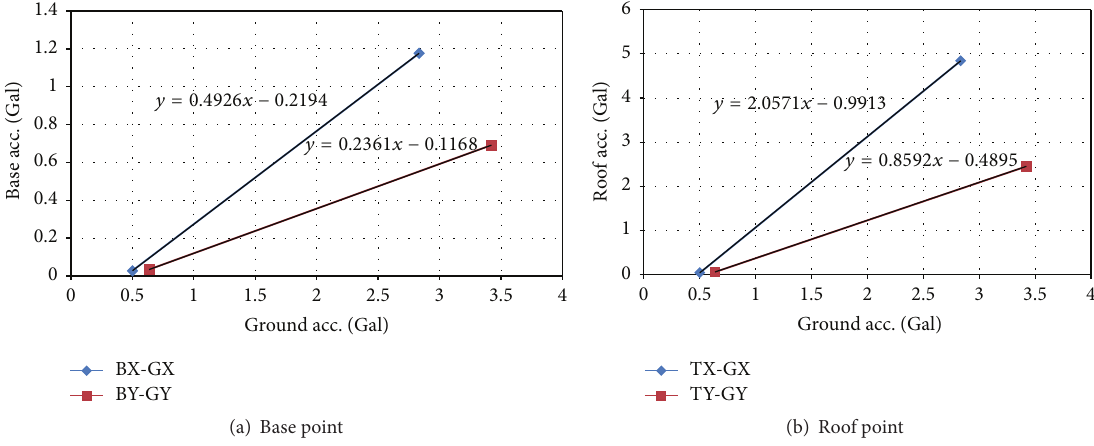
Figure 7: Linear fitting between the free-field response and the building different sensors